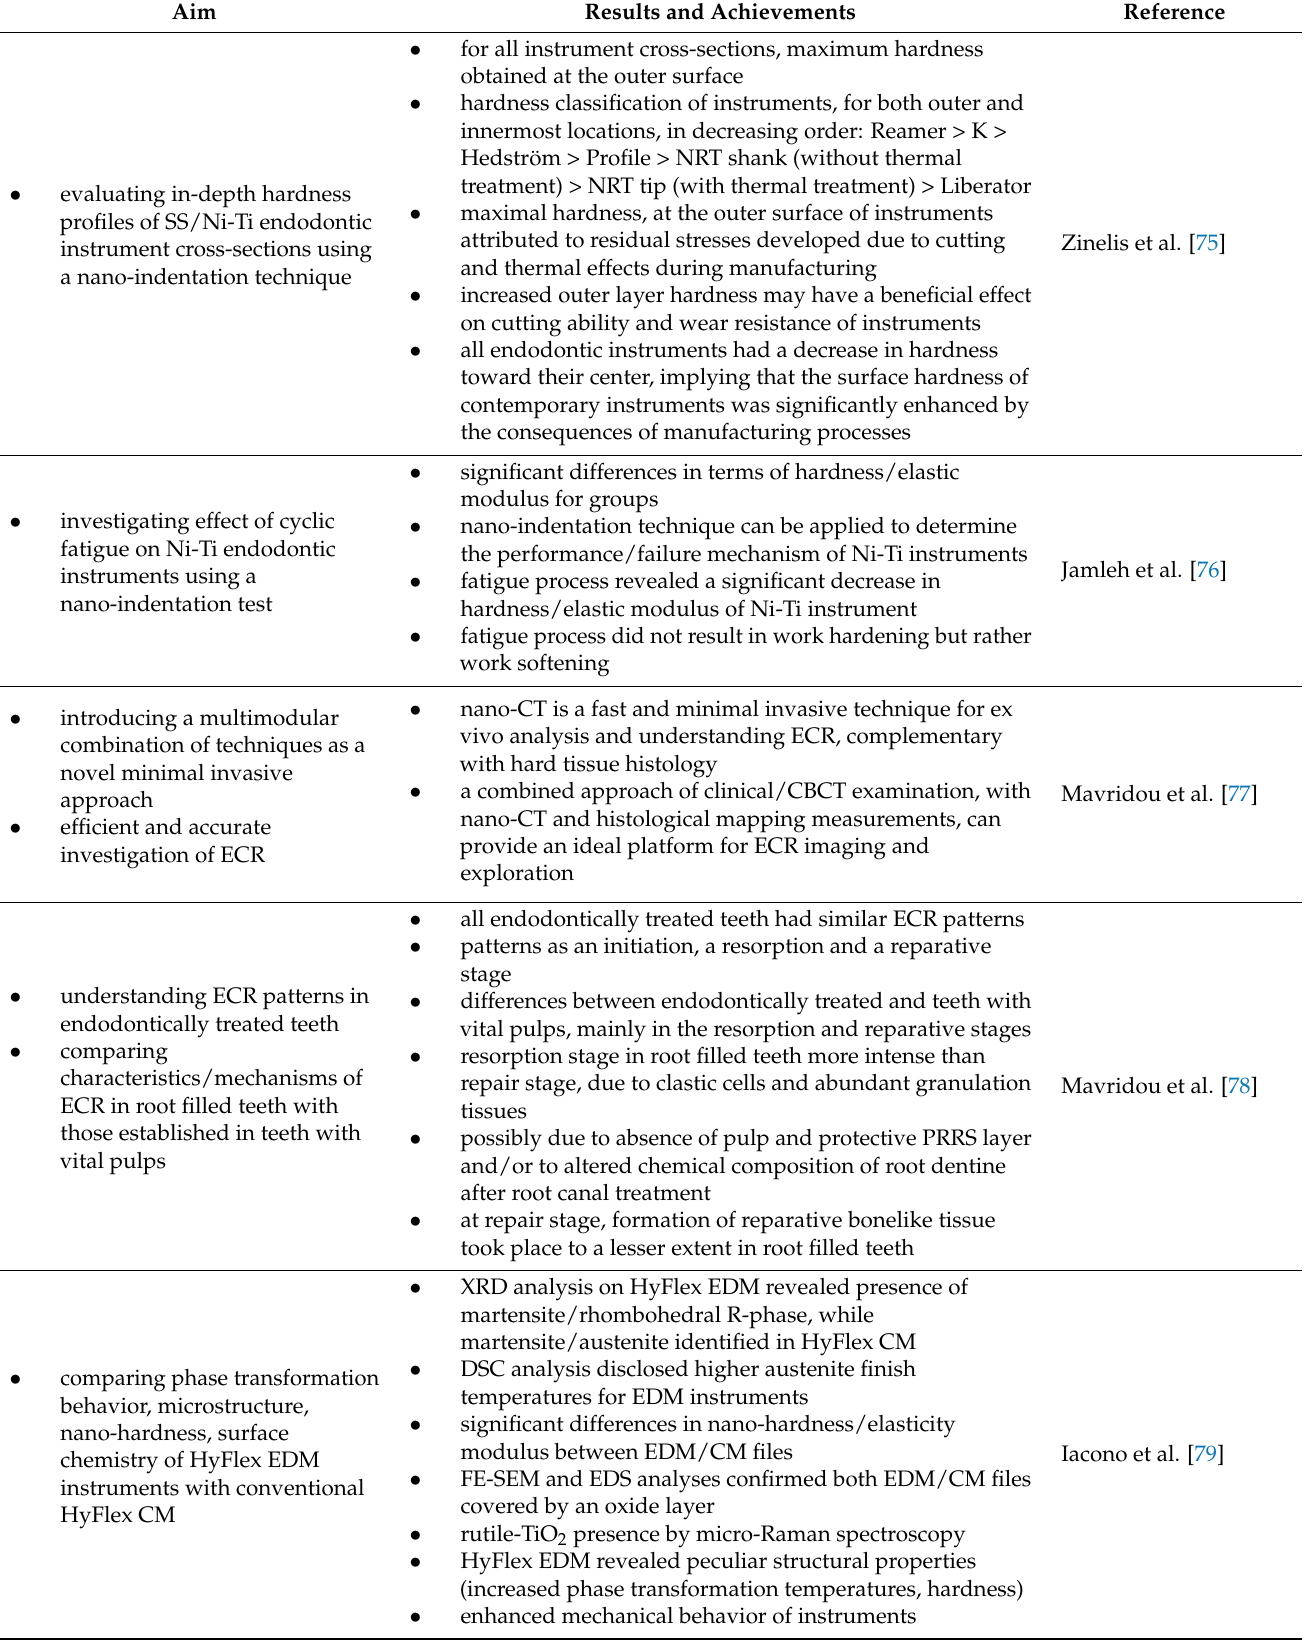
Table 4. Achievements related to nanotechnology applications in endodontics: nano-testing of structures. Aim Results and